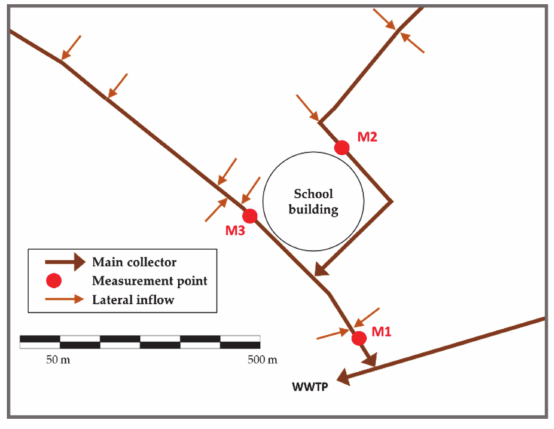
Figure 2. Location of the designated heat recovery site (own